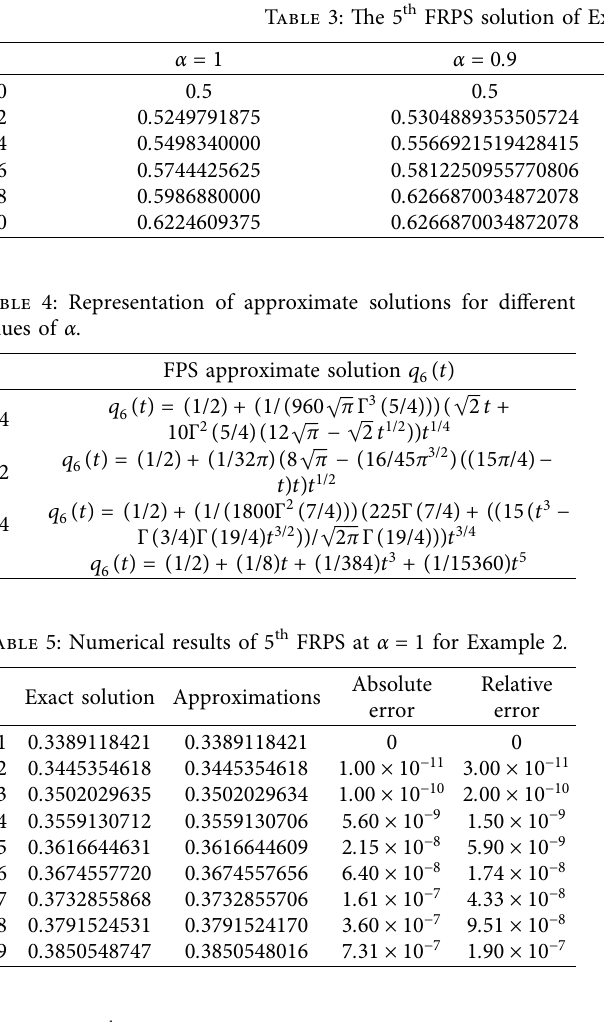
Table 6: The 5 th FRPS solution of Example 2 for different values of t and α .